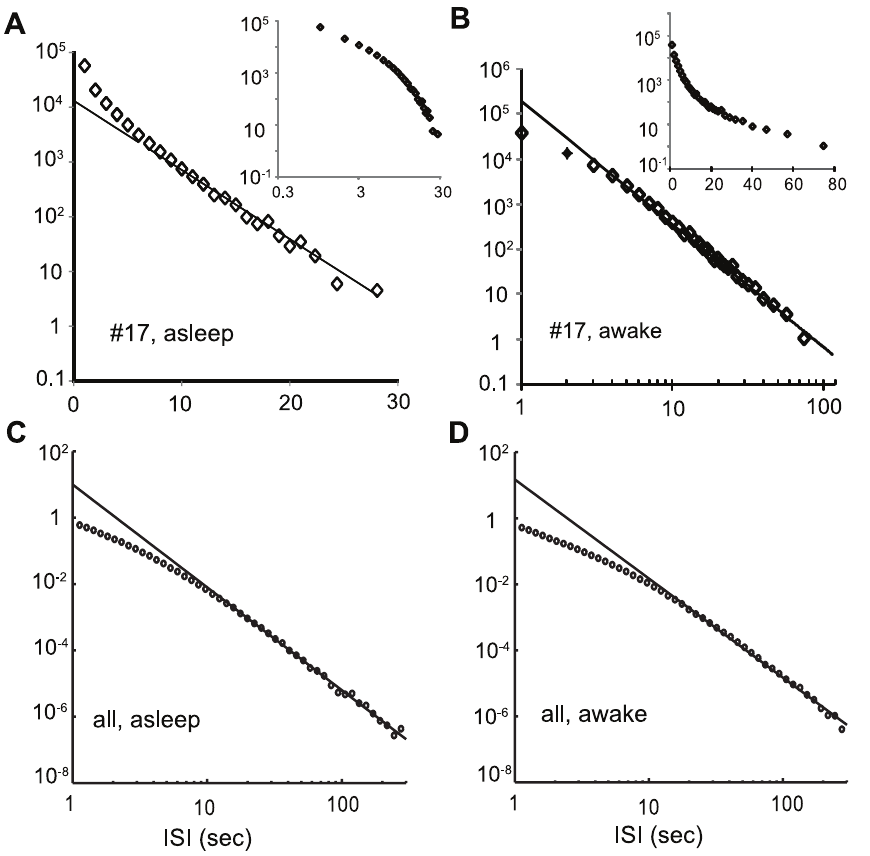
Figure 4. Tails of the ISI distributions. Tails of the ISI distribution of neuron # 17 during sleep (A) and waking (B) are plotted either in log-linear or log-log coordinates. The insets illustrate that the alternative plots (log-log in sleeping, log-linear in waking) result in a poorer linear fit in the range where the original plots exhibited a linear tendency. (C)(D) The histograms of ISI’s taken during the sleeping (waking) period of all the analyzable spike trains are averaged and plotted in log-log coordinates.